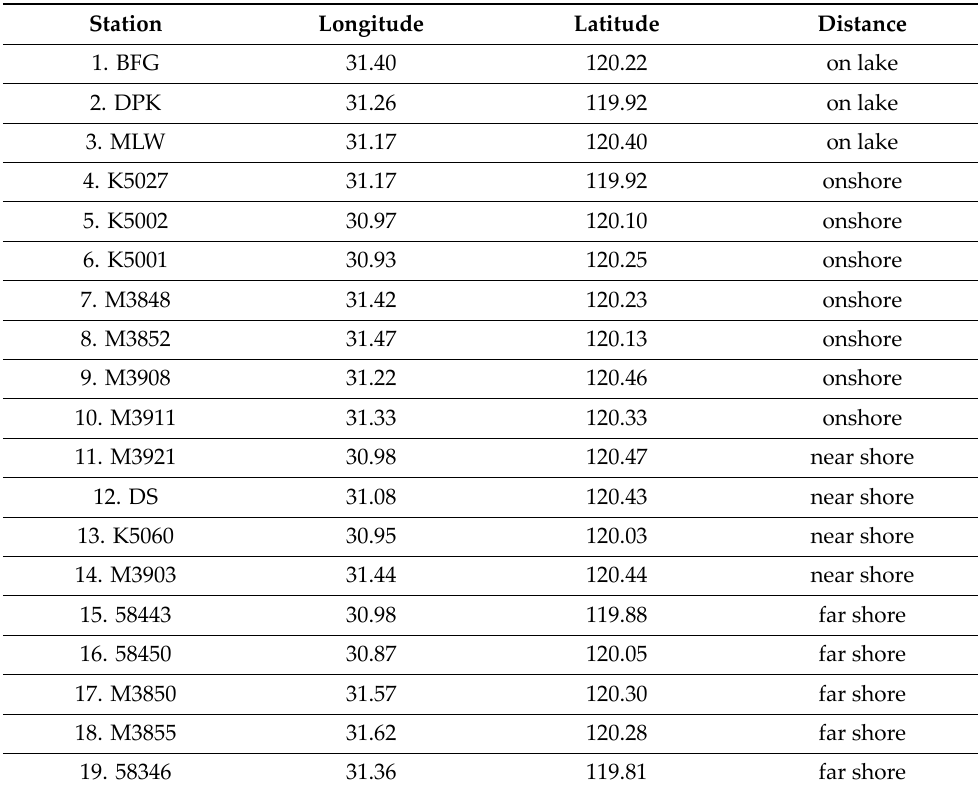
Table 1. 19 site information: 16 measurement points on land and 3 on the